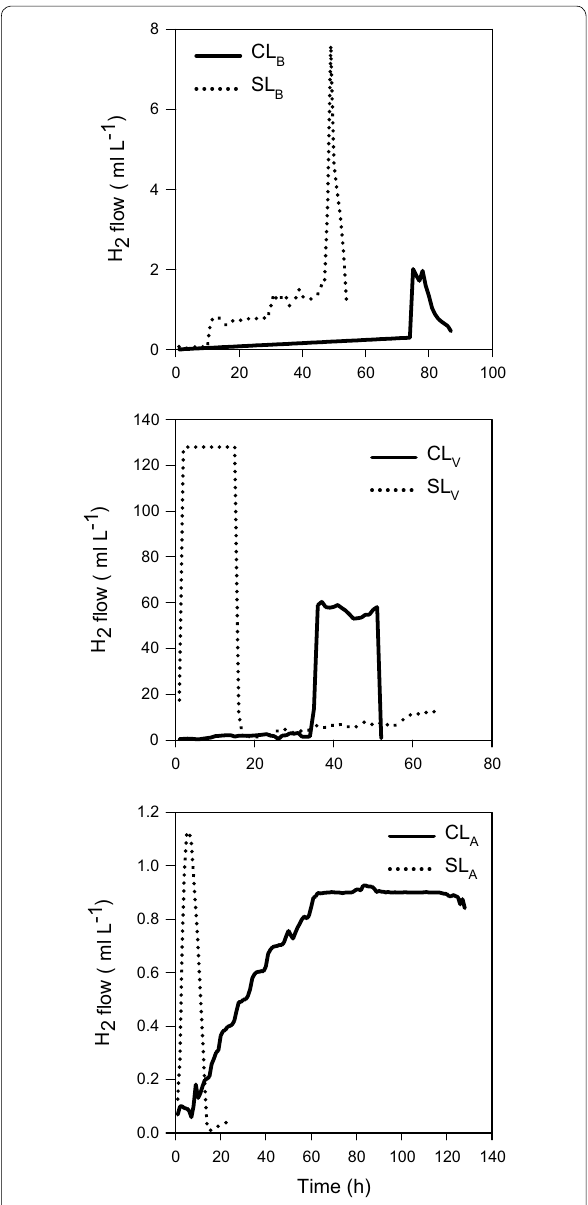
Fig. 1 H 2 production by C. vulgaris and S. obliquus immobilized under different wavelength (white, blue and purple